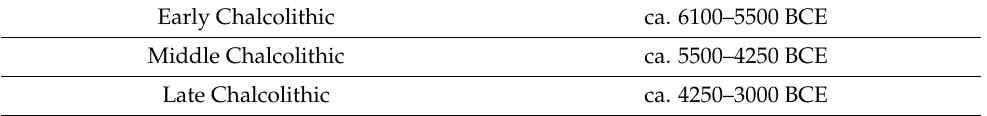
Table 1. Chalcolithic periodization used in the text (based on Schoop 2011a).